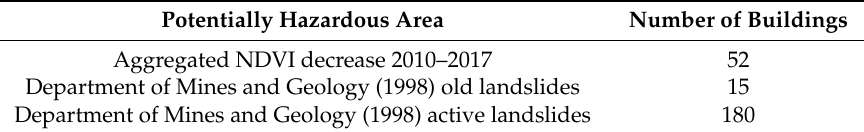
Table 3. Buildings on the shoreline of Phewa lake.